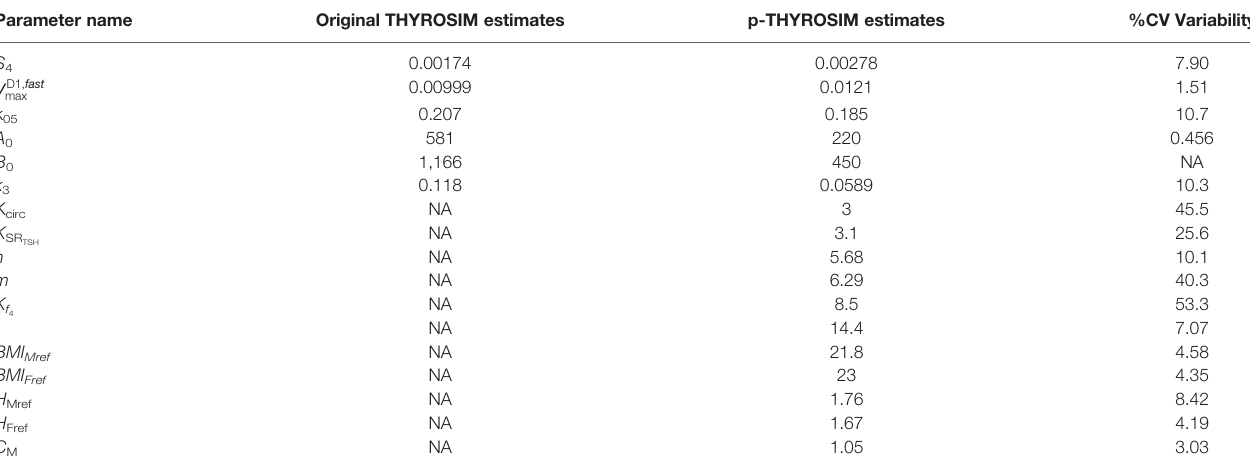
TABLE 1 | Comparison of old and new parameter estimates and their %CVs (percent coef fi cients of